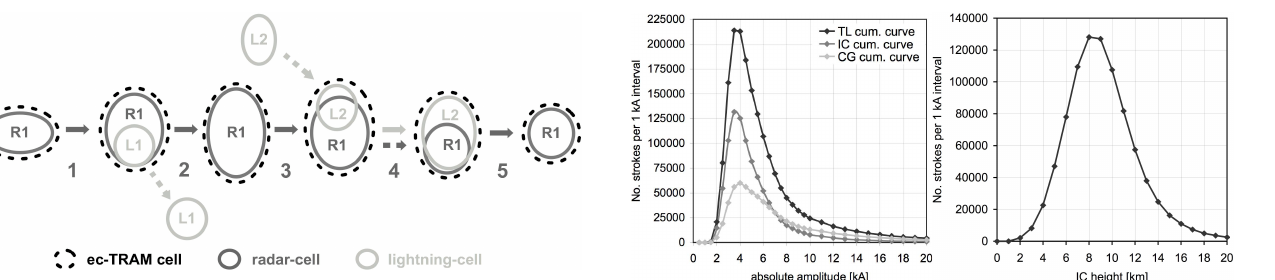
Fig. 3. The number density distributions of (left) absolute discharge amplitudes calculated for the total lightning data set and (right) for the IC discharge heights of those lightning events with amplitudes higher than